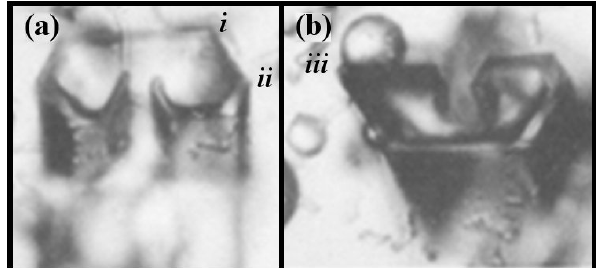
Figure B10. Scrolls formed on crystals of approximate diameter of 60µm. (From the cloud chamber, courtesy of Akira